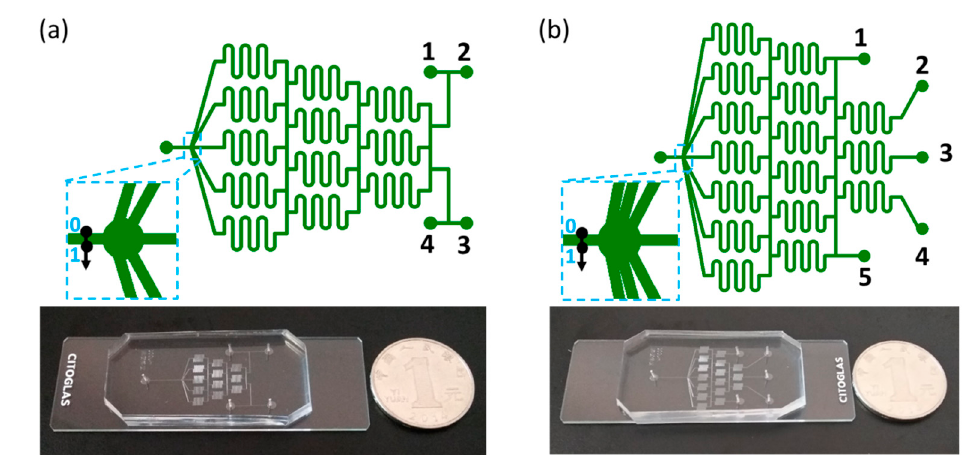
Figure 1. Schematic of the type IV ( a ) and type V ( b ) concentration gradient makers used in this work, and the corresponding experimental microfluidic chips fabricated with glass-polydimethylsiloxane (PDMS) by soft lithography and plasma bonding. Here, 1, 2, 3, 4, and 5 denote the five